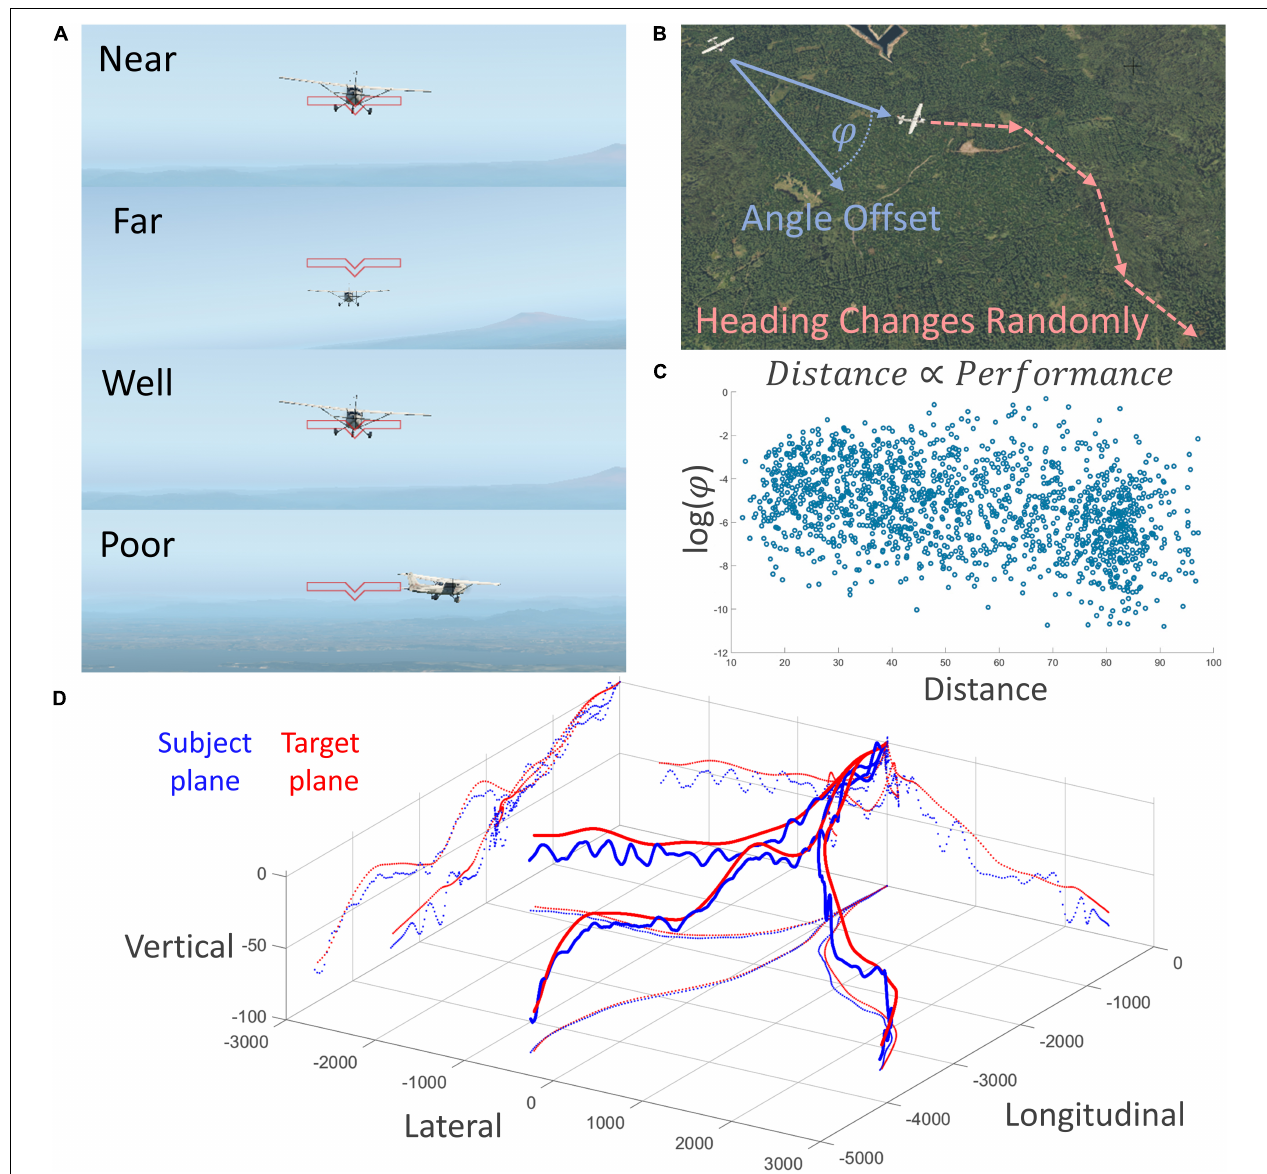
FIGURE 1 | Description of the experimental task conducted in the fMRI scanner. (A) First-person depiction of two behavioral variables of interest: experimentally manipulated distance (top two) and performance (bottom two). (B) Subjects were tasked with training a crosshair on the target airplane, which changed headings randomly. Performance was measured as log of three-dimensional angle offset; negative is better. (C) Behavioral results showed a strong relationship between distance and performance; flying farther away was easier. (D) Three-dimensional depiction of three runs of subject and target plane trajectories; note the constant course correction of the